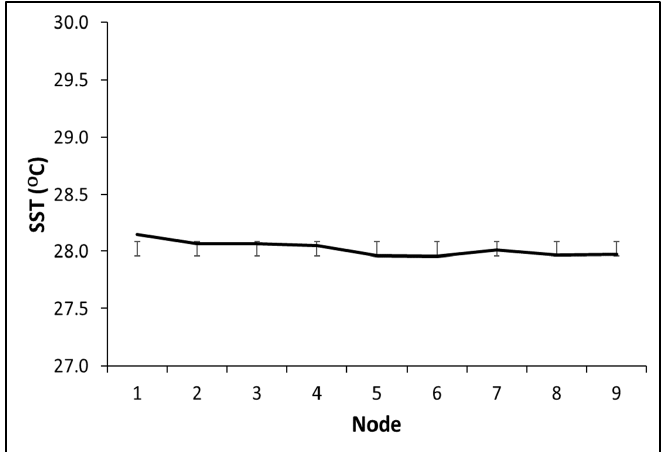
Figure 7. Average SST variation of each 1° × 1° node in the study area. The black, straight lines indicate the standard error.